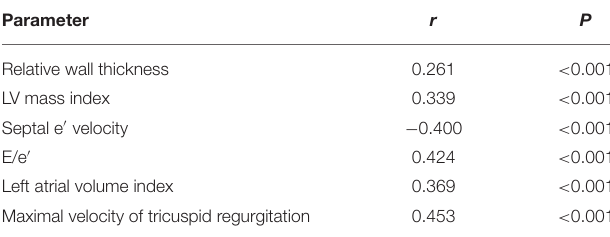
TABLE 3 | Simple correlations of baPWV with indices of LV geometry and diastolic